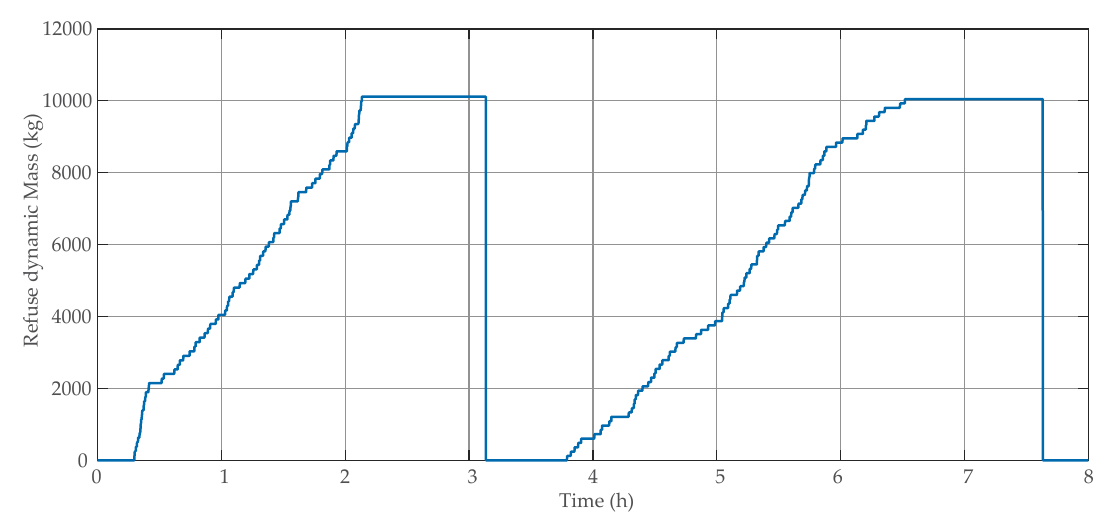
Figure 7. Dynamic weight profile related to the refuse collector process of an RCV.